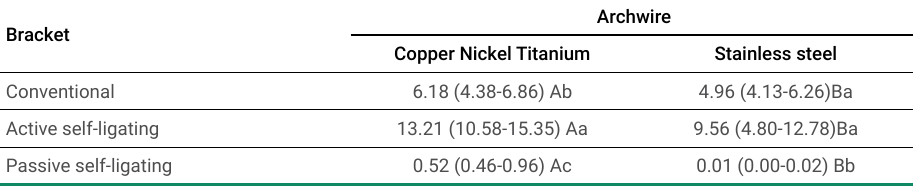
Table 1. Median (minimum and maximum values) of frictional force (N) considering bracket and type of archwire